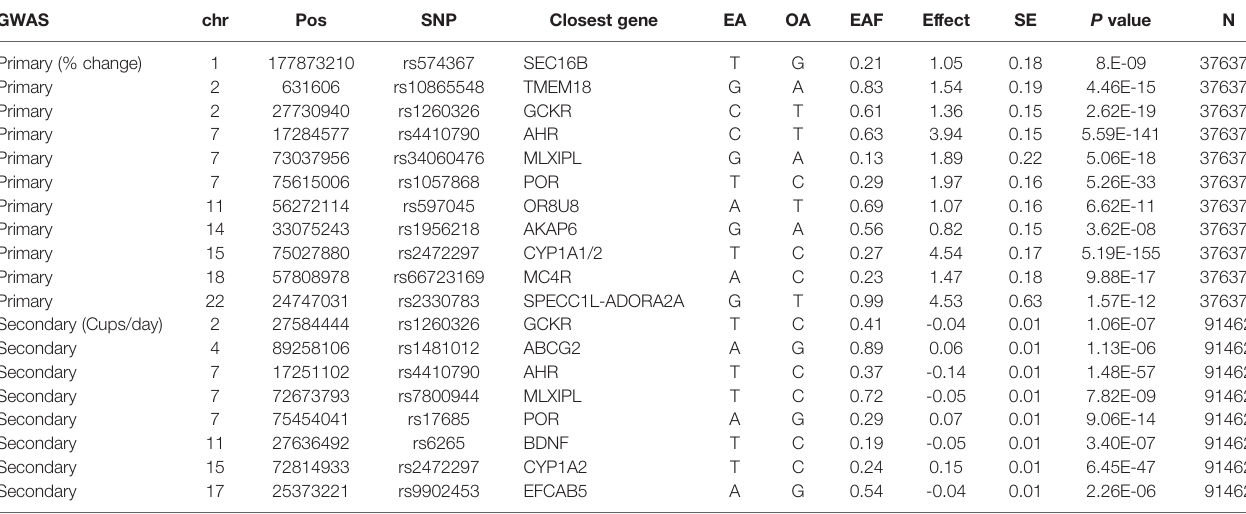
TABLE 1 | Characteristics of SNPs for habitual coffee consumption from the GWAS meta-analysis.